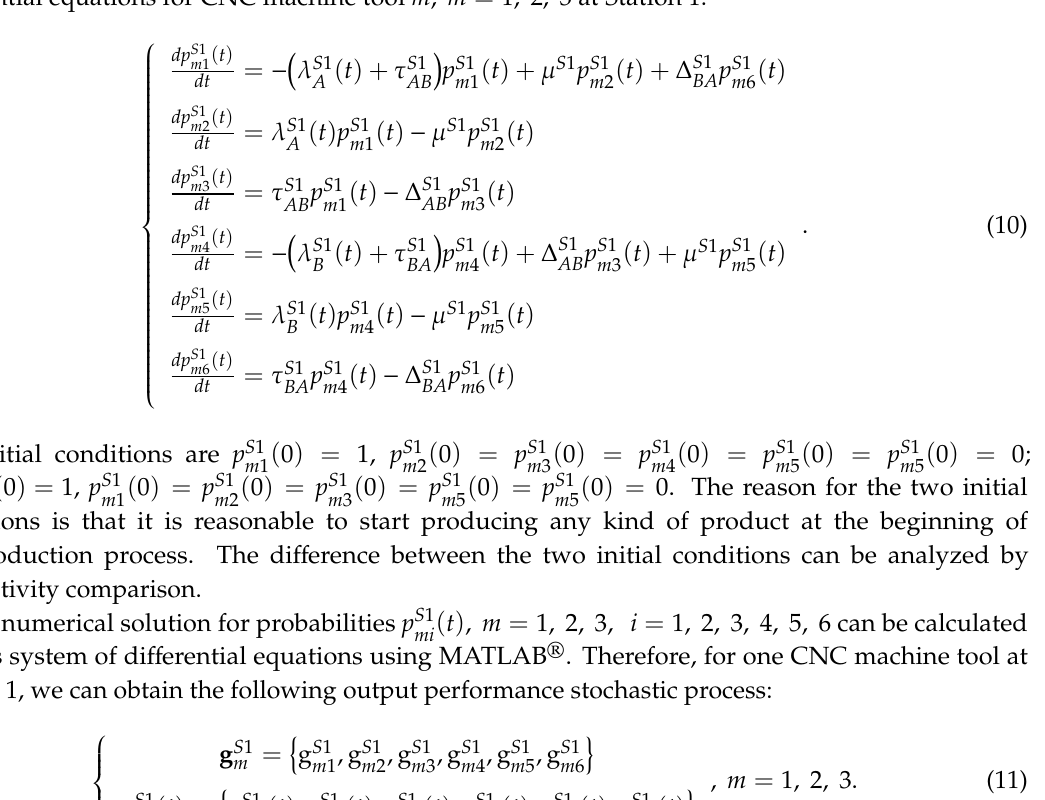
di ff erential equations for CNC machine tool m , m = 1, 2, 3 at Station